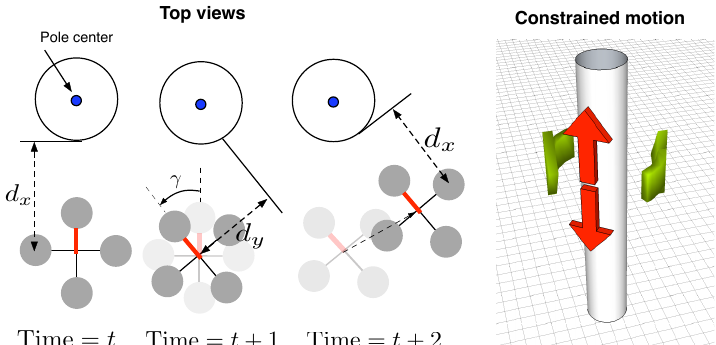
Figure 16. ( left ) illustration of how vehicle induces yaw motion. γ is an angle for the yaw motion and d and d are distances between the pole and the robot in x-, and x y y-axis; ( right ) reduced dimension task space for operator commands which is sufficient for inspection purposes.